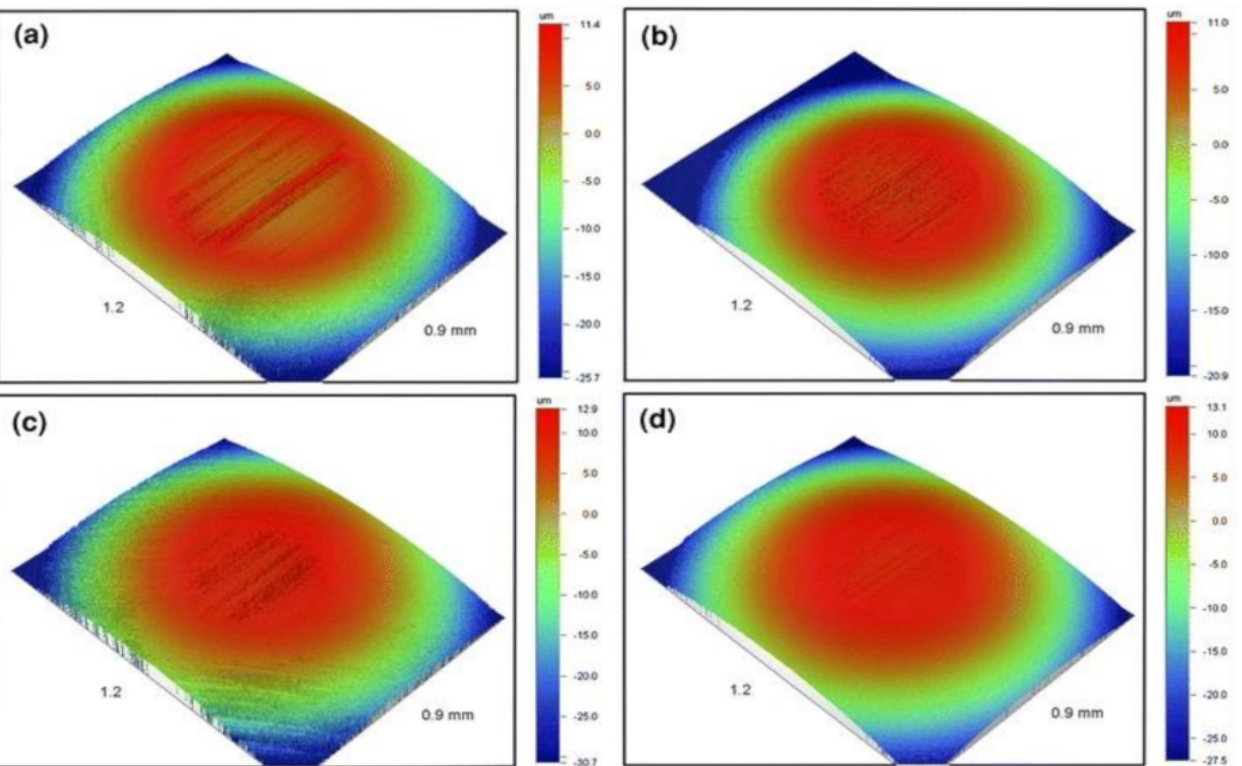
Figure 12. ( a ) The lubricating performance of oil without dithiocarbamate additives compared with the oil incorporated with dithiocarbamates ( b ) DBB-EBzDTC ( c ); DOB-EBzDTC and ( d ) DOB-EEDTC. Reprinted with permission from Springer Nature, Tribology letters [210]. Copyright